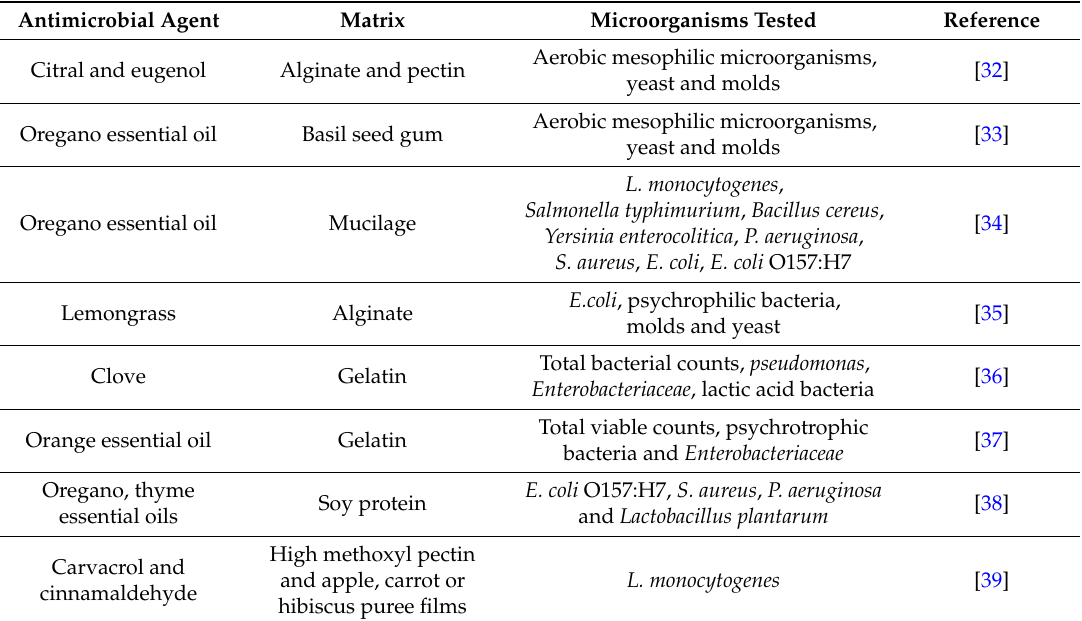
Table 1. Antimicrobial activity of some edible